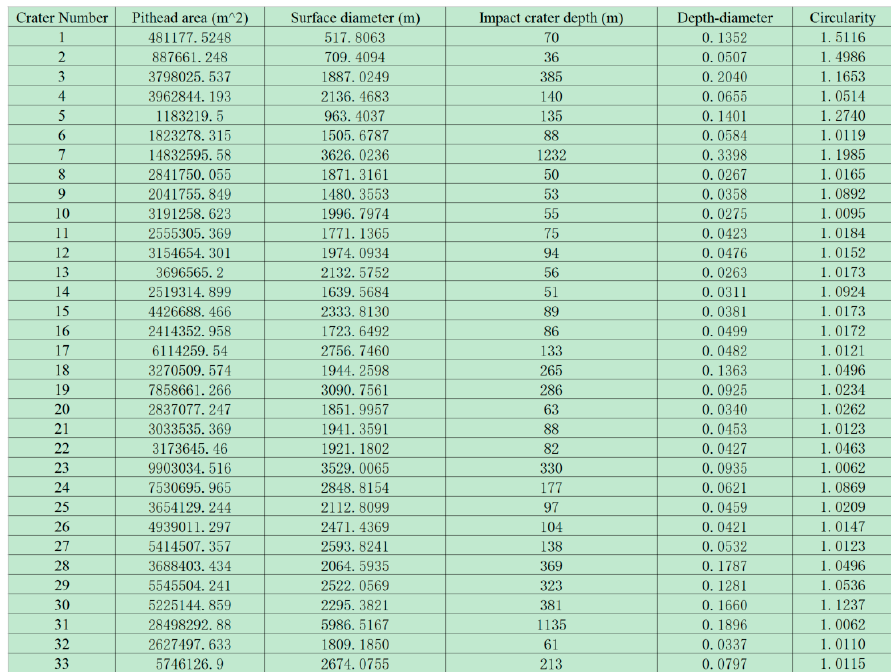
Figure 17. Detection results of the heterogeneity analysis case study. ISPRS Int. J. Geo-Inf. 2018 , 7 , x FOR PEER REVIEW